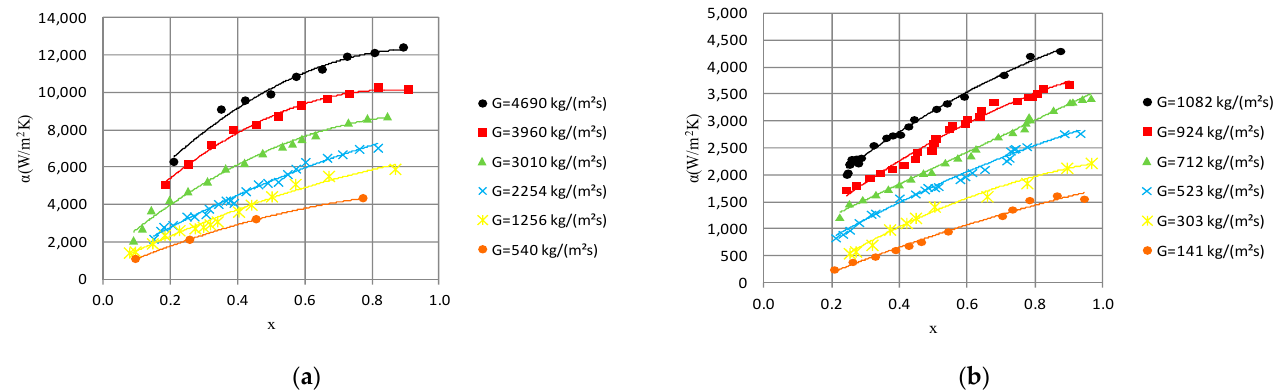
Figure 5. Dependence of heat transfer coefficient on average vapor quality α = f(x a ) during HFE 7000 condensation in minichannels with internal diameter: ( a ) d i = 1.2 mm, inlet T s = 39 ◦ C; ( b ) d i = 2.5 mm, inlet T s = 42 ◦ C.